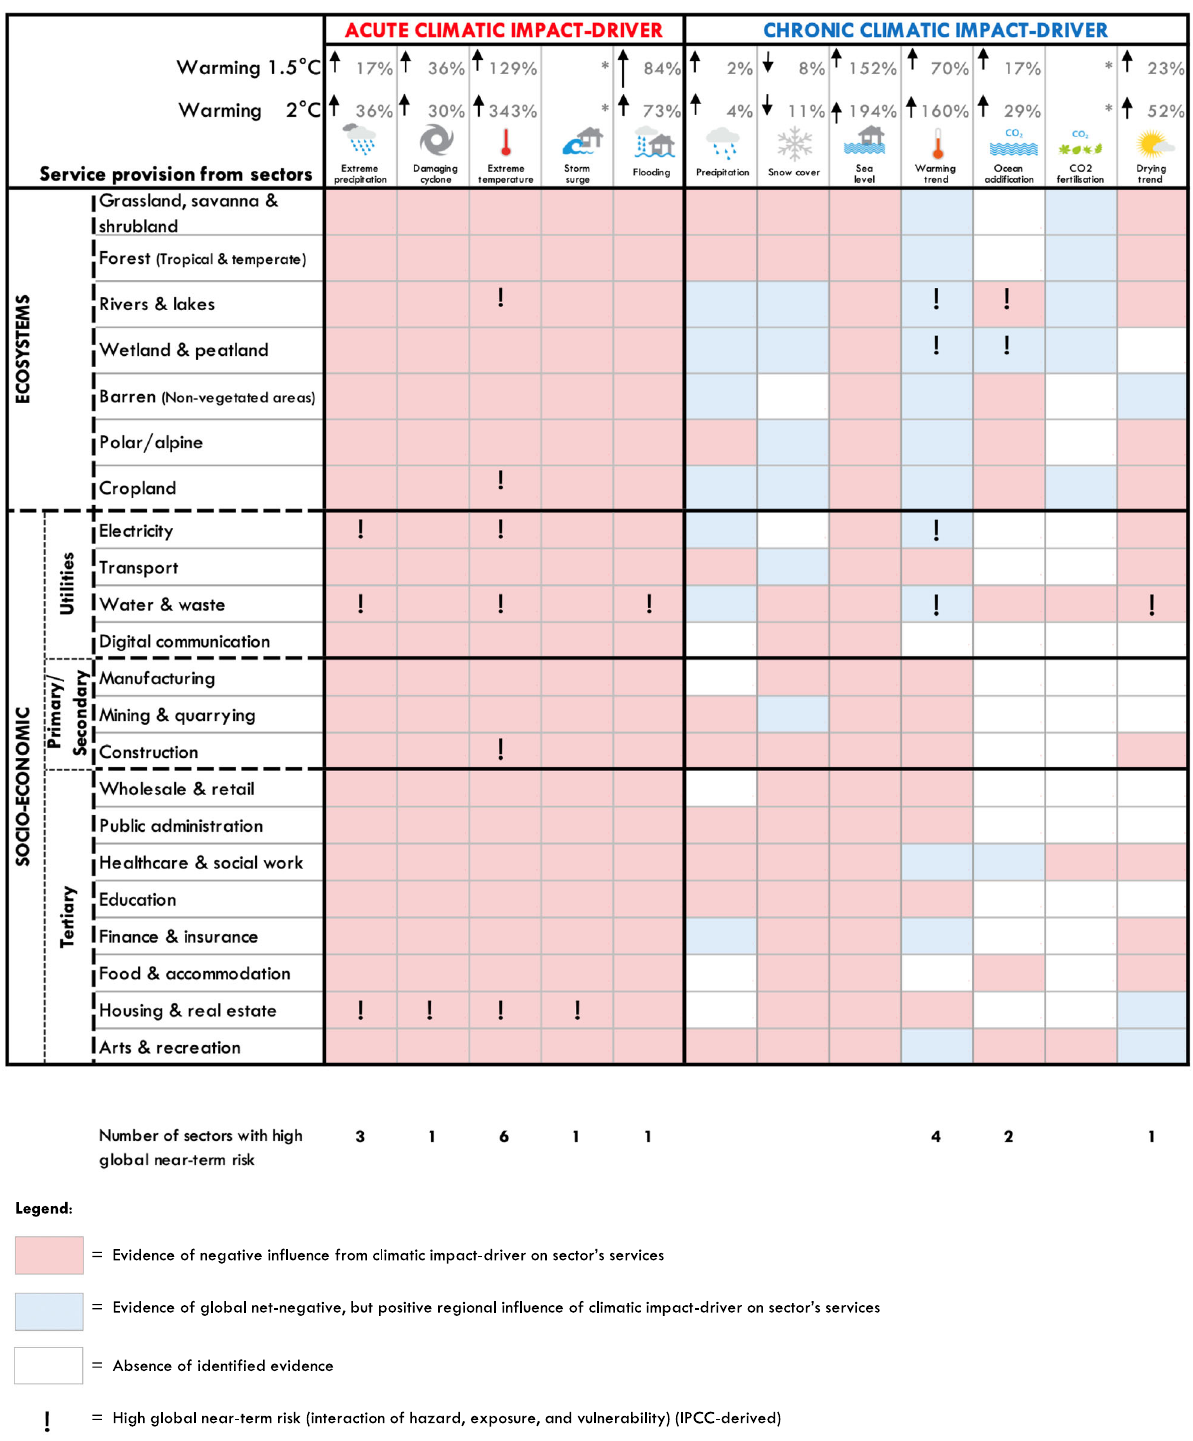
Fig. 4 Ecosystems and socio-economic sectors in fl uenced by acute and chronic climatic impact-drivers. Red shading denotes evidence of a negative effect, blue shading highlights a potential positive regional effect of a climatic impact-driver on a sector. White shading indicates the absence of identi fi ed evidence. Percentages for climatic impact-drivers signify changes in frequency under a 1.5 and 2 °C scenario (see Supplementary Data Tab 3.3), whereby the symbol * suggests that no quanti fi ed evidence was identi fi ed. The symbol ** denotes the grey boundaries on whether a drying trend and droughts are classi fi ed as chronic or acute climatic impact-drivers (see Supplementary Data Tab 2.1 for de fi nition and justi fi cation). Exclamation marks represent high near-term risk based on IPCC AR5 TS.4 16